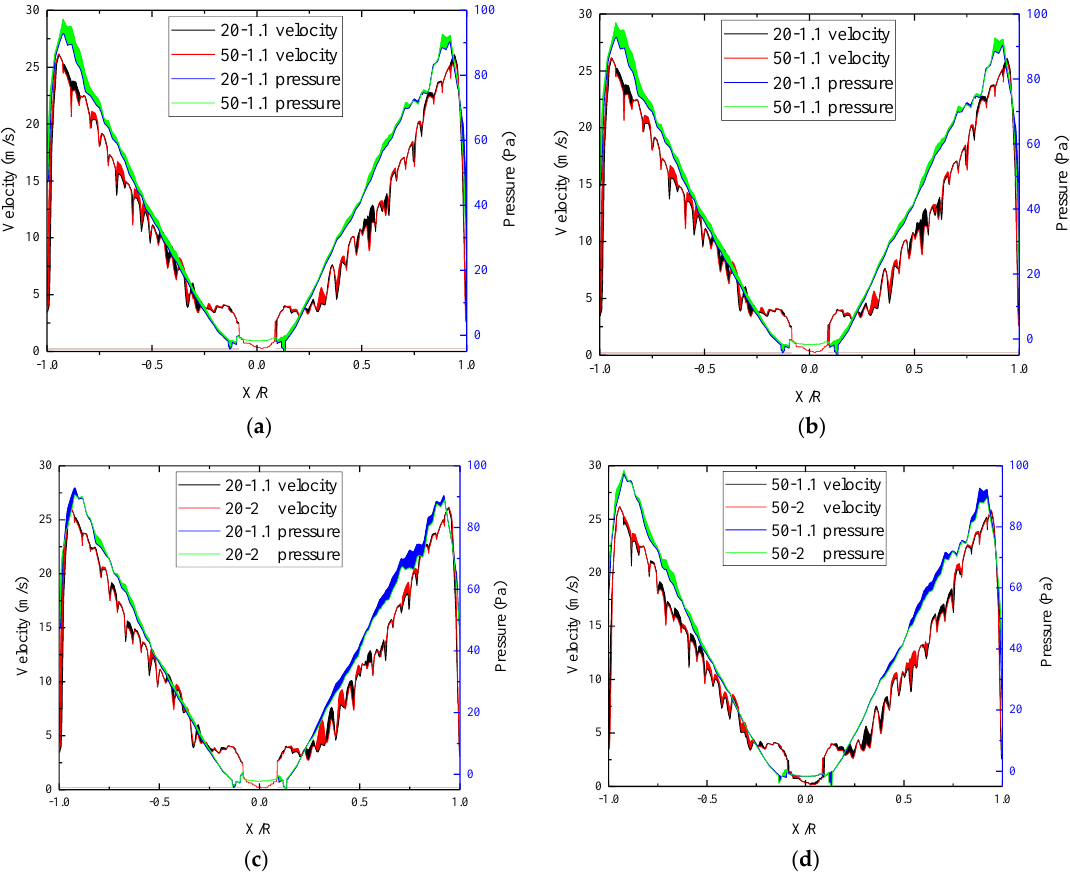
Figure 14. Pressure and velocity distribution of the lower surface of rotor 4 with different configurations: ( a ) 20-1.1 and 50-1.1; ( b ) 20-2 and 50-2; ( c ) 20-1.1 and 20-2; ( d ) 50-1.1 and 50-2.